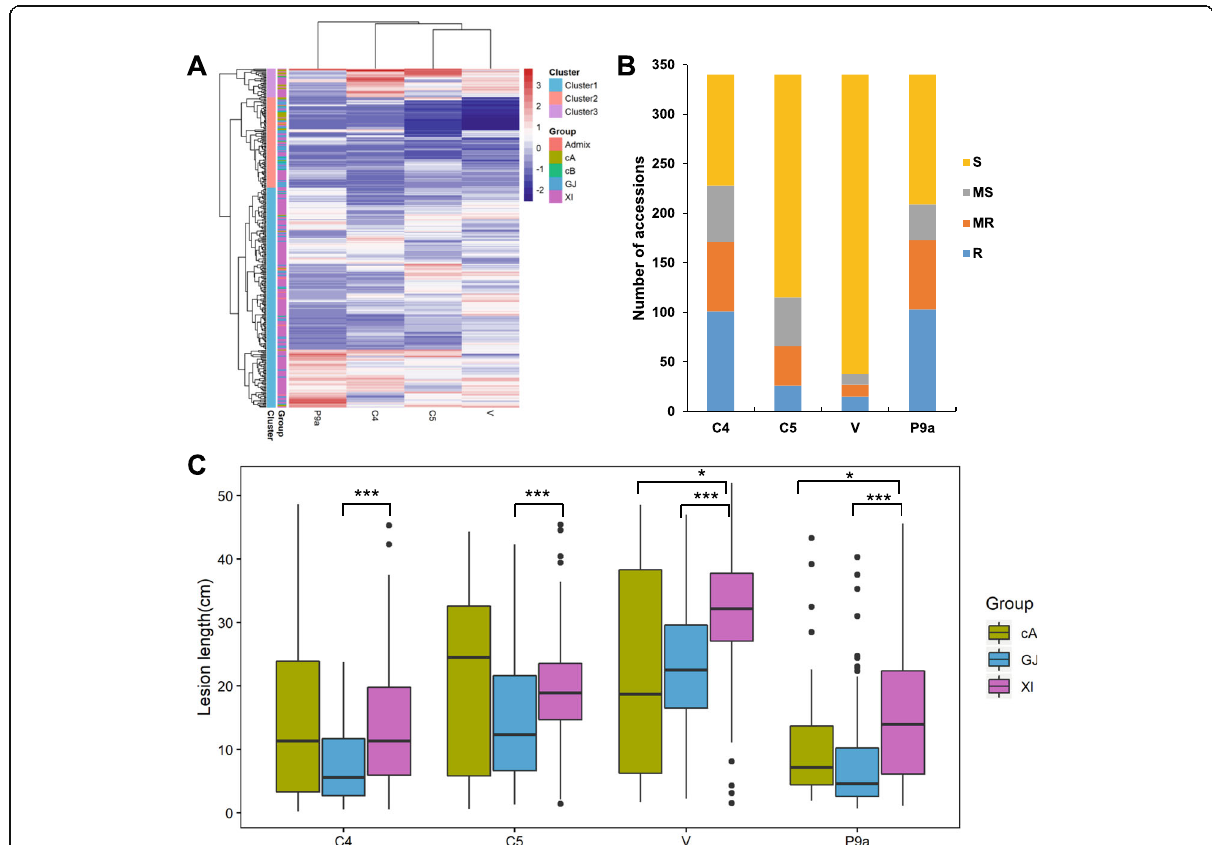
Fig. 2 Bacterial blight resistance evaluation of 340 rice accessions inoculated with representative Xoo strains from China and Philippines. a Hierarchical cluster of accessions and strains based on lesion length (LL). b Number of accessions showing different reactions to four Xoo strains. R (LL<5cm), MR (5cm ≤ LL<10cm), MS (10cm ≤ LL<15cm), S (LL ≥ 15cm). c Boxplots for LL of four Xoo strains in three major subgroups. Box edges represent the 0.25 and 0.75 quantiles with median values indicated by bold lines. * and *** denote significant differences in mean LL among subpopulations at P <0.05, 0.001,